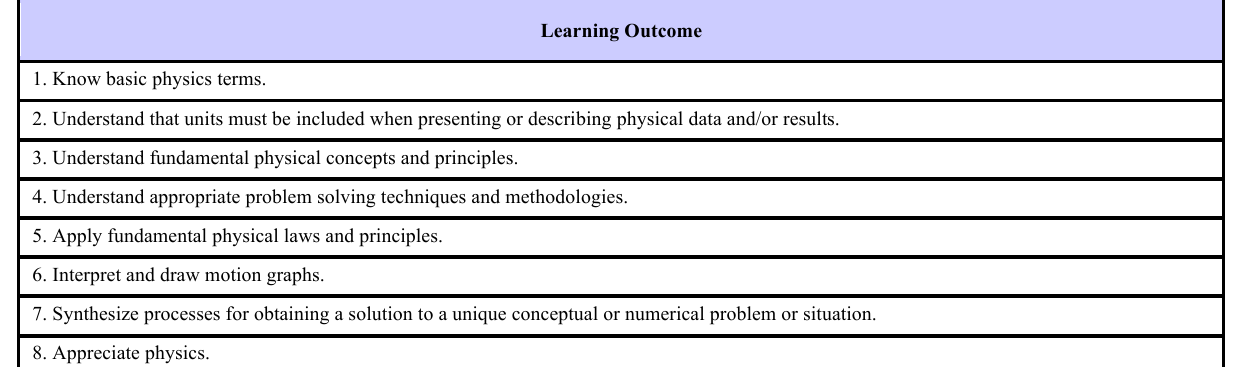
TABLE I. C OURSE -S PECIFIC L EARNING O UTCOMES Learning